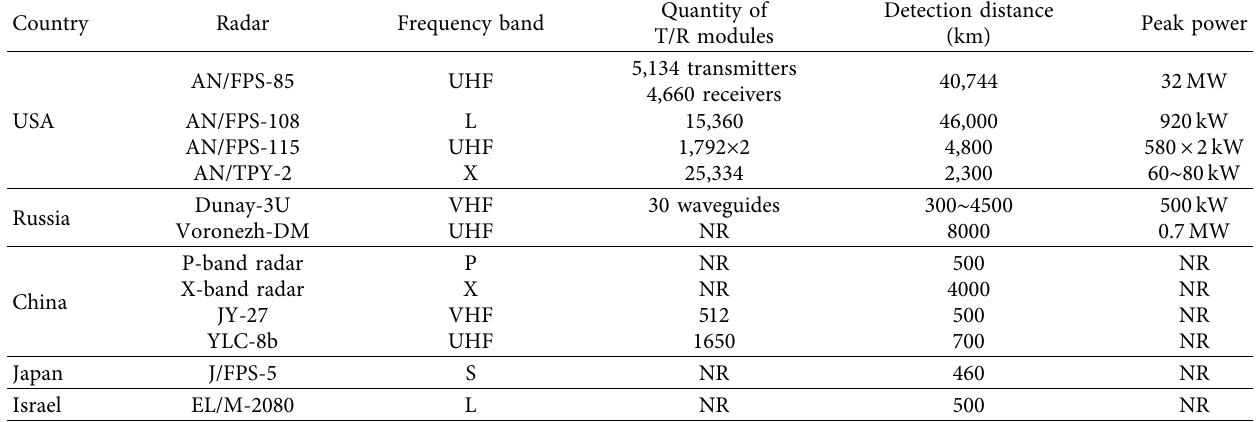
Table 1: Main parameters of diferent